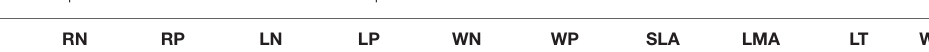
TABLE 2 | Spearman correlation coefficients of 13 plant functional traits within different